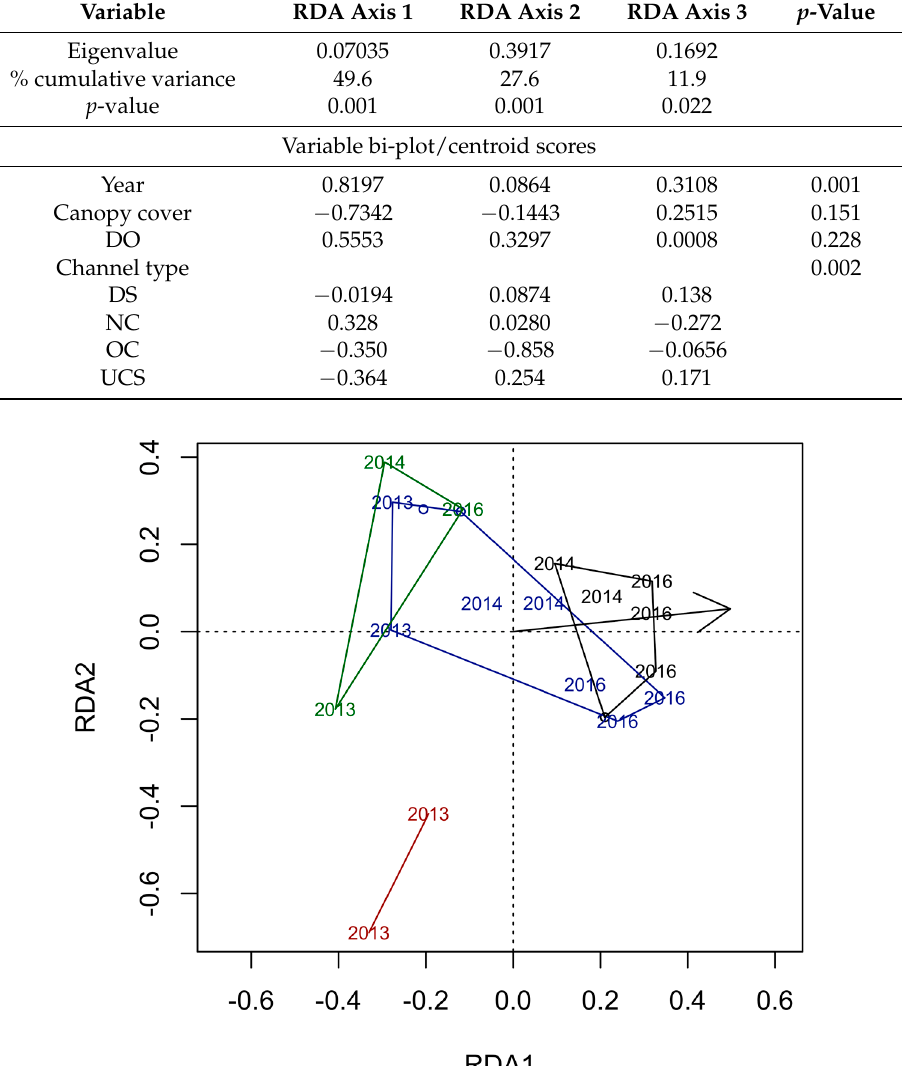
Table 2. Summary table of redundancy analysis (RDA) results from fish communities at all sampling sites across all years constrained by channel type, year, canopy cover, and dissolved oxygen (DO). Bi-plot scores for continuous constraining variables and centroid scores for channel type (DS = downstream sites, NC = new channel sites, OC = old channel sites, and UCS = the upstream control site) are presented for the first three RDA axes. p -values indicated for RDA axes and constraining variables were calculated using permutation ANOVA.